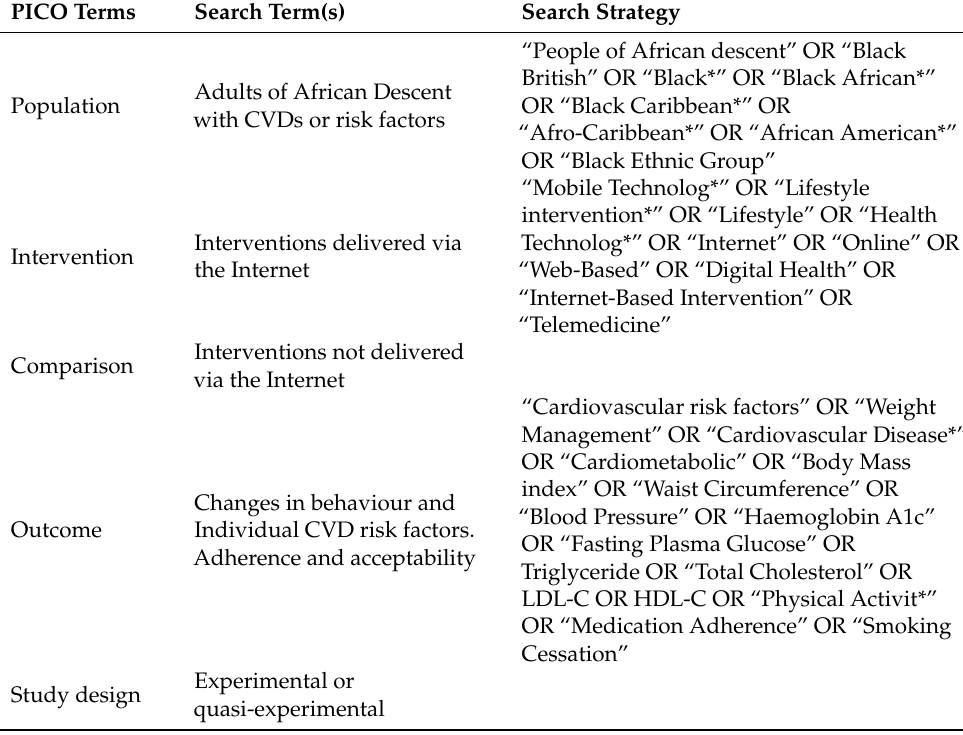
Table 1. Search Strategy as Defined by the PICOS